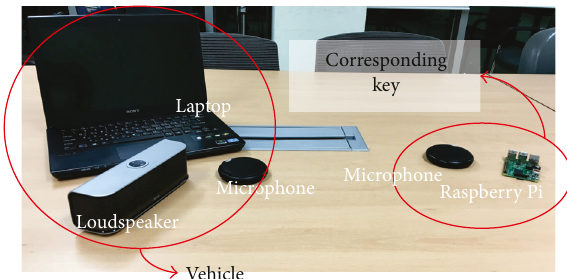
Figure 3: Experimental